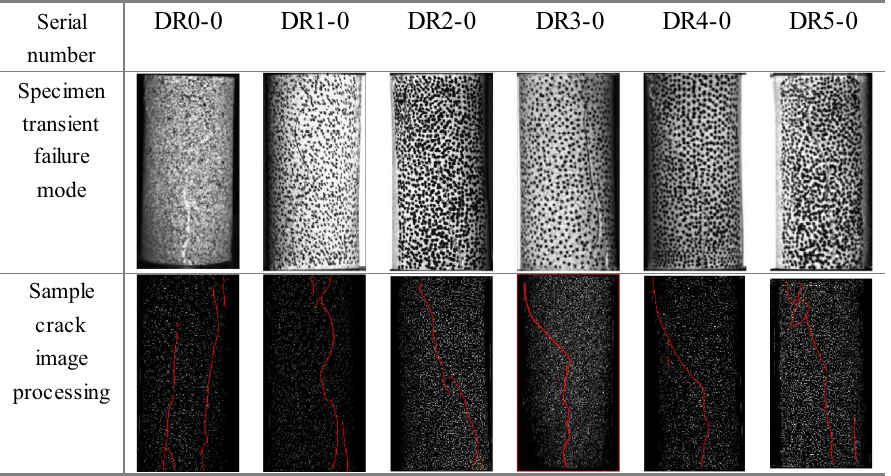
Table 4. Macroscopic damage characteristics of pre-peak unloading damaged white